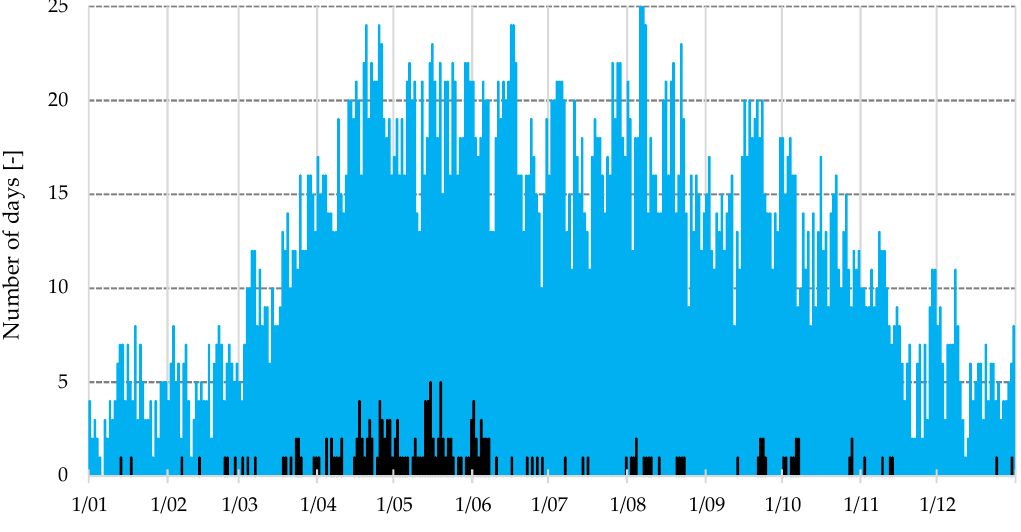
Figure 8. Seasonal dynamics of the number of days with conditions potentially favorable to initiation and particularly conducive to intensification of aeolian processes in the Polish Baltic coastal zone—a case study on Świnoujście 1961–2010.